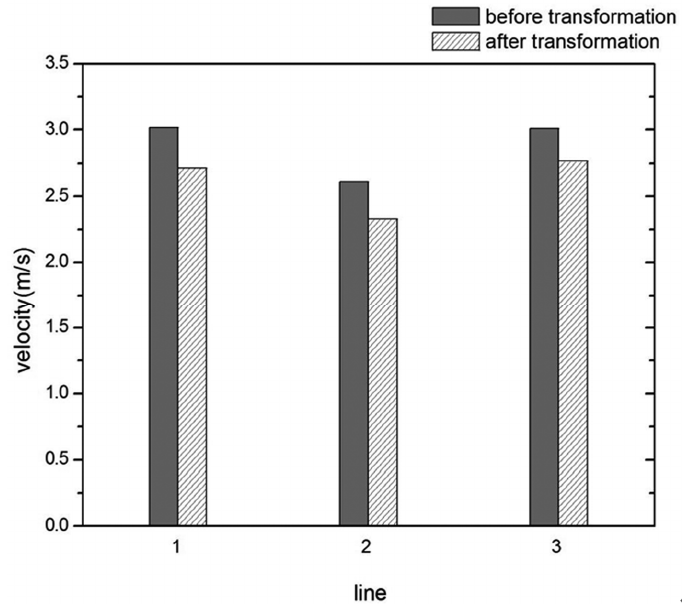
Figure 10. The average wind speed change on the three observation lines before and after the planned transformation.